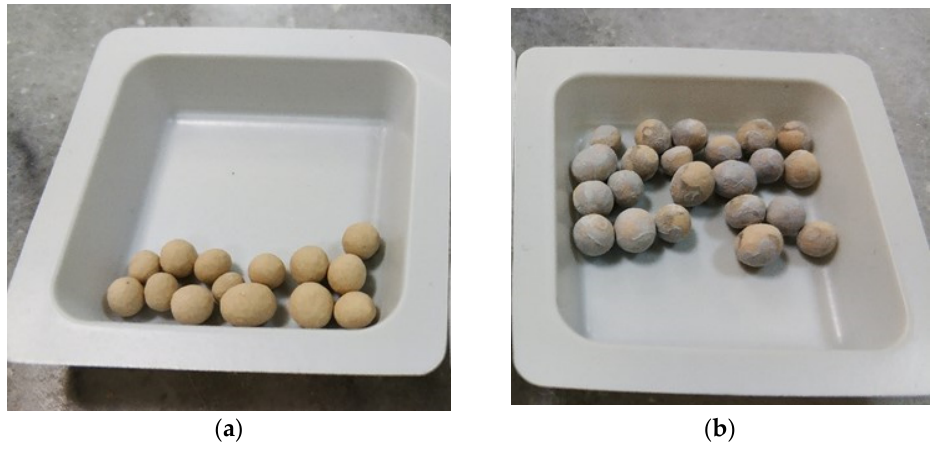
Figure 1. Duranit balls ( a ) before and ( b ) after the ZnO deposition.